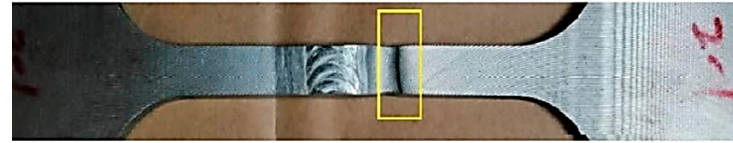
Figure 4. Fracture location of the tensile specimen.